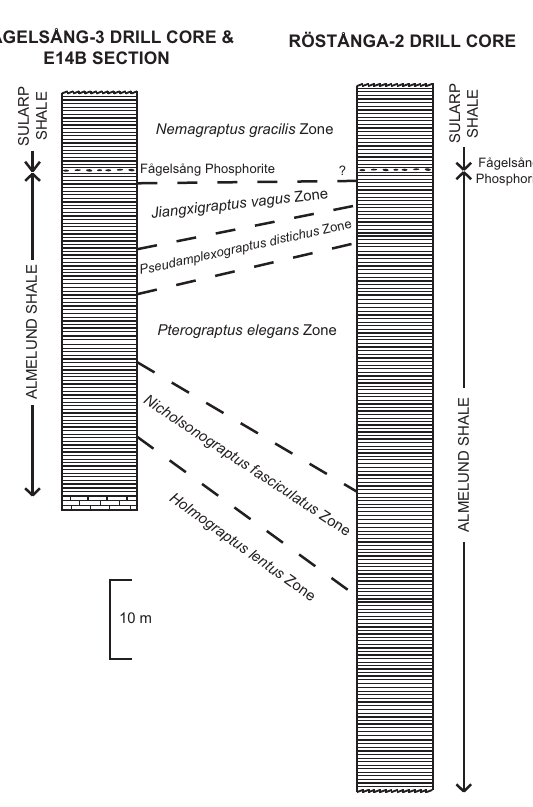
Fig. 4. Comparison between the estimated stratigraphical thickness of the middle–upper Darriwilian graptolite zones at Fågelsång (based on the Fågelsång­3 drill core and locality E14b) and the Röstånga­2 drill core. The calculated thicknesses are based on an assumed average dip of 10 degrees at Fågelsång and 38 degrees at Röstånga. As noted in the text, the precise level of the base of the Nemagraptus gracilis Zone remains undetermined in the Röstånga­2 drill core due to the absence of zone index graptolites in the uppermost Almelund Shale and lowermost Sularp Shale. As shown in this figure, the calculated thicknesses of the various graptolite zones in the two successions are similar except those of the Pterograptus elegans and Holmograptus lentus zones, which appear much thicker in the Röstånga­2 drill core. As noted in the text, this may be an artifact due to strata duplication by